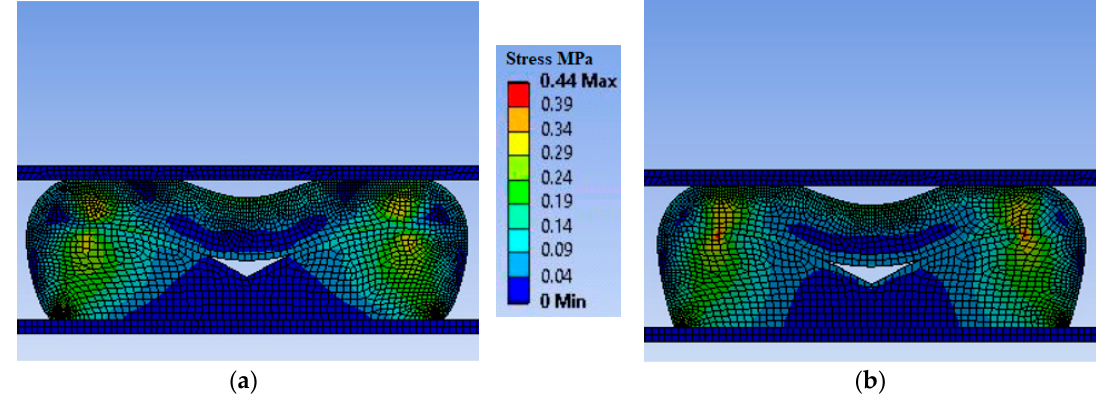
Figure 11. Contour plot of equivalent stress for simulations: ( a ) Plane Stress Assumption; ( b ) Plane Strain Assumption.